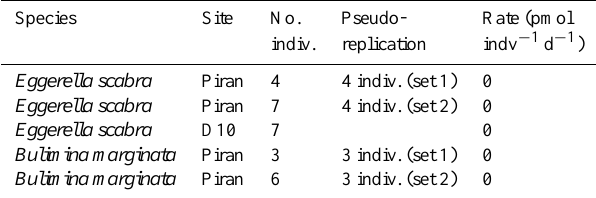
Table 7. Denitrification rates of the two tested species from two different sites. The number of individuals added to the measurement chamber is indicated. In two cases some individuals were reused in a second set of measurements, generating pseudoreplication; the number of individuals used in the second set of measurements is